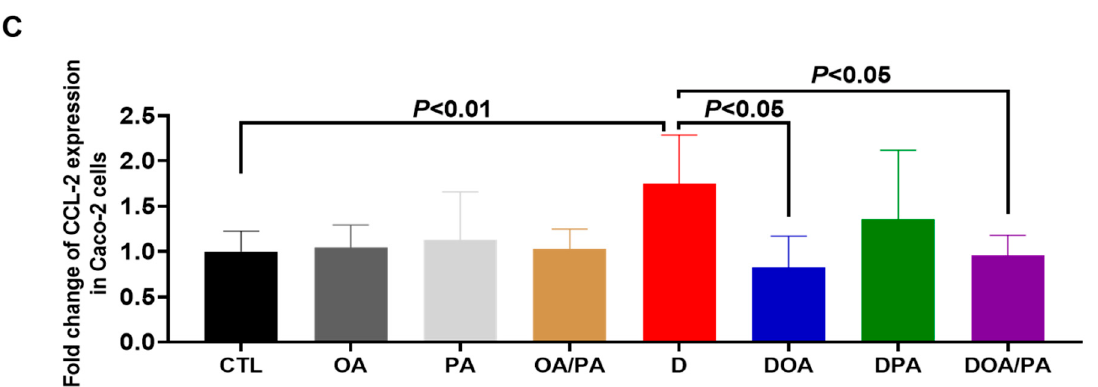
Figure 2. Effect of fatty acids on the modulation of proinflammatory cytokine expression in DSS- treated Caco-2 cells. Relative expression levels of ( A ) TNF α , ( B ) IL-8, and ( C ) CCL-2 mRNA in Caco-2 cells challenged with 1.5% DSS. CTL: control group (Caco-2 cells alone); OA: Caco-2 cells treated with OA; PA: Caco-2 cells treated with PA; OA/PA: Caco-2 cells treated with PA and OA; D: Caco-2 cells challenged with 1.5% DSS; DOA: Caco-2 cells challenged with 1.5% DSS and treated with OA; DPA: Caco-2 cells challenged with 1.5% DSS and treated with PA; DOA/PA: Caco-2 cells challenged with 1.5% DSS and treated with PA and OA. The results were obtained from three independent experiments.